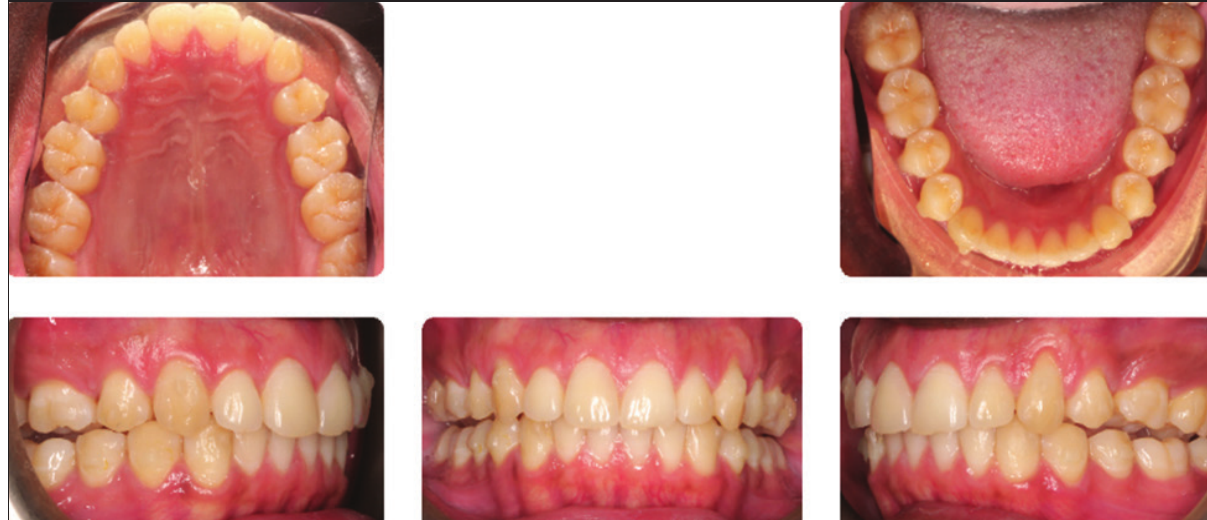
Figure 12. Case at completion of the initial series of aligners, before additional aligners, showing especially the left side posterior open bite.